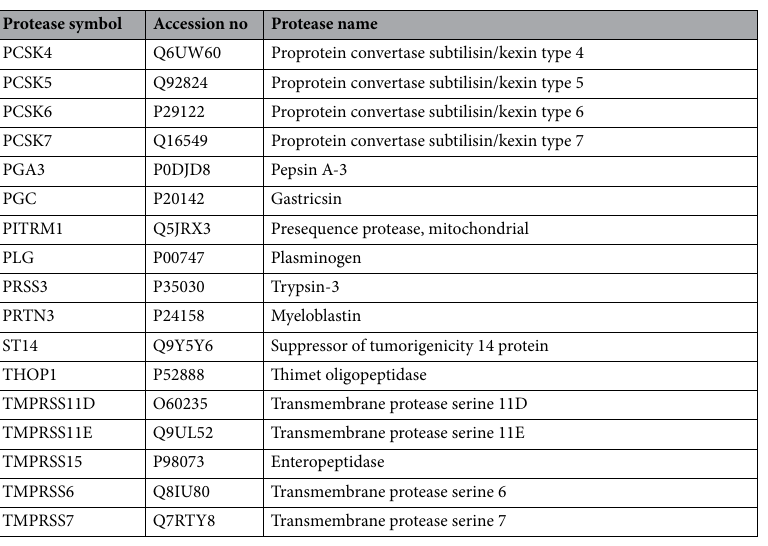
Table 1. List of all proteases (symbols, accession numbers, and names) predicted by